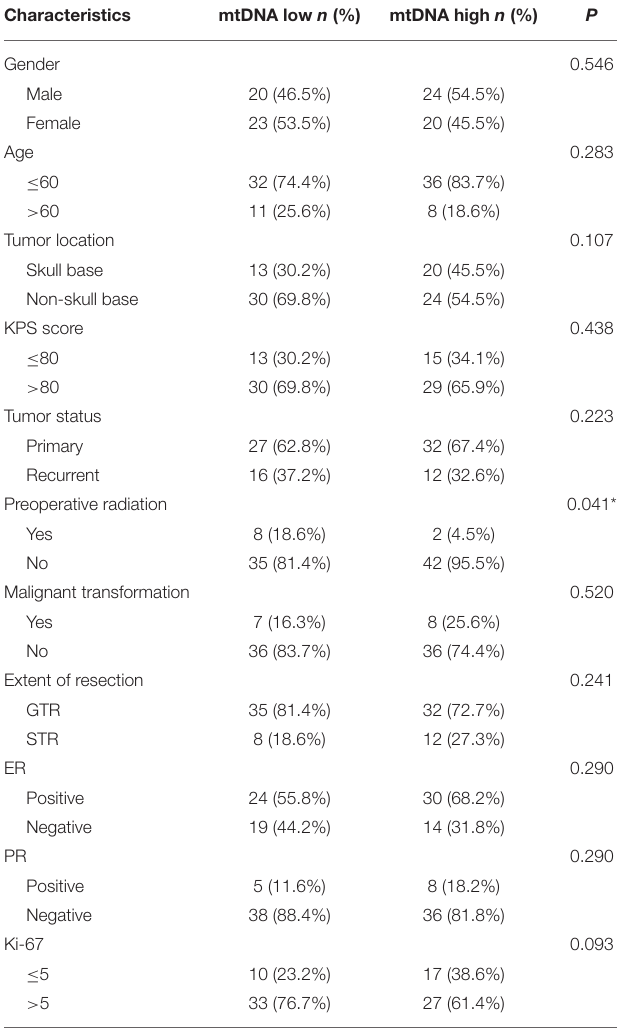
TABLE 1 | Association between mtDNA content and clinicalpathological variables of Grade III meningioma patients.